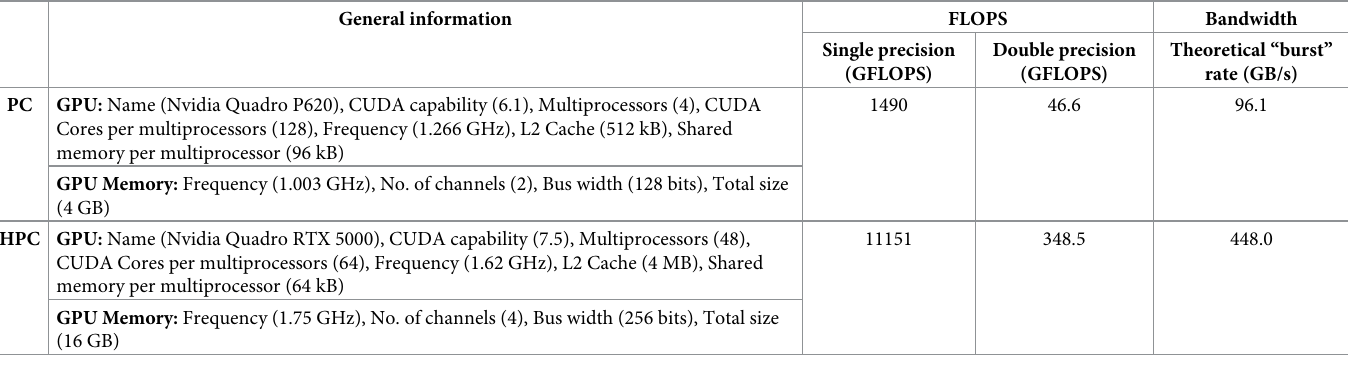
Table 4. Information of the tested GPU